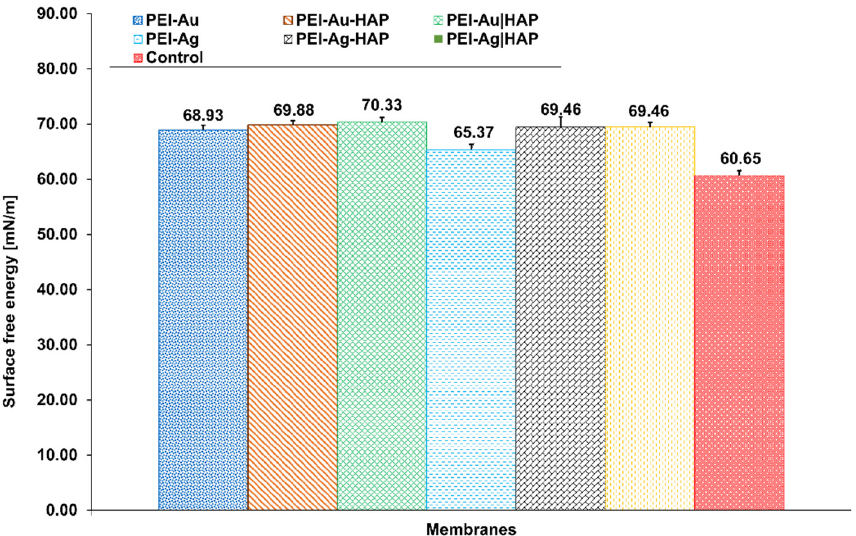
Figure 3. Surface free energy of the composite membranes. Key to symbols: I. Membranes with AgNPs: polyethyleneimine membrane with AgNPs (PEI-Ag); bilayer consisting of polyethyleneimine with incorporated AgNPs and hydroxyapatite (PEI-Ag|HAP); polyethyleneimine with AgNPs and HAP complex (PEI-Ag-HAP). II. Membranes with AuNPs: polyethyleneimine with AuNPs (PEI-Au); bilayer consisting of polyethyleneimine with incorporated AuNPs and hydroxyapatite (PEI-Au|HAP); polyethyleneimine with AuNPs and HAP complex (PEI-Au-HAP). The values are presented as mean ± SD.